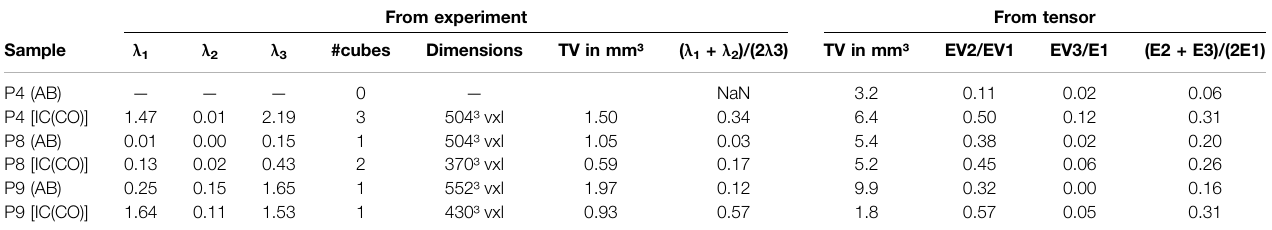
TABLE 3 | Summary of the fl uid simulations quantifying the direction-dependent permeability of the different bone specimens.